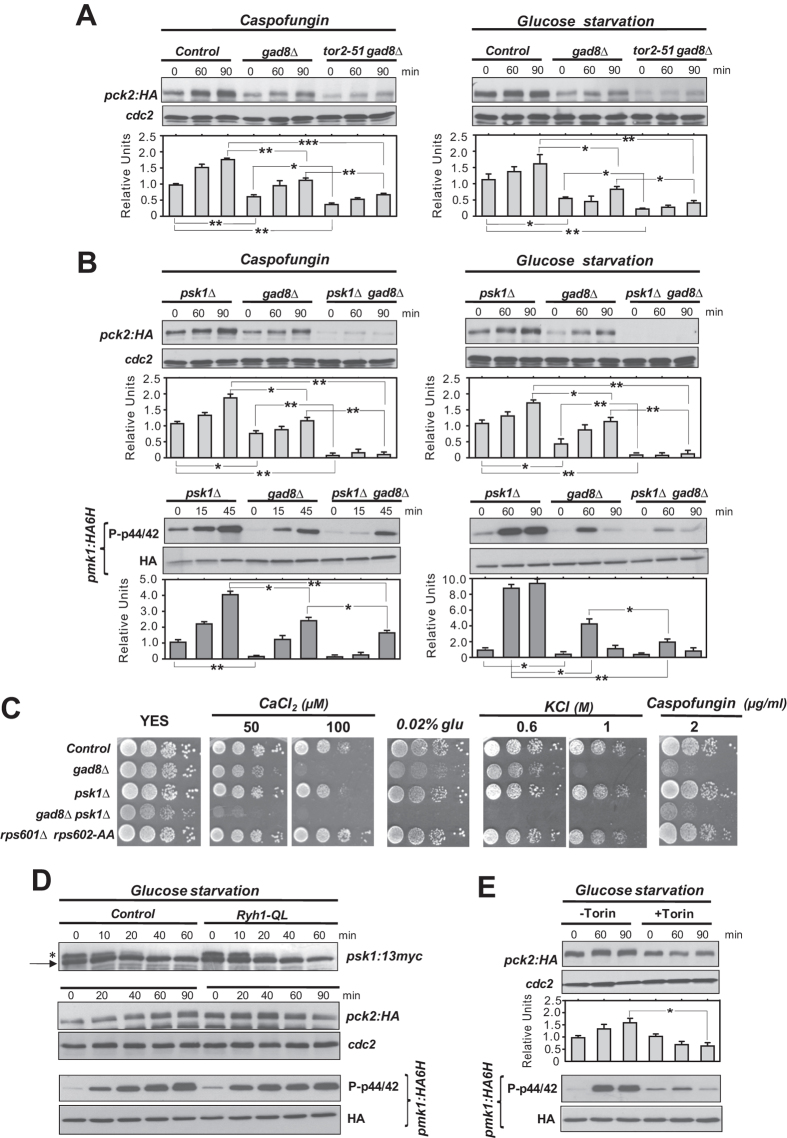
TORC1-Psk1 participates with TORC2-Gad8 in increasing Pck2 levels and Pmk1 activation during growth and stress.(A) Cultures of strains BV8 (Pck2-HA; control), BV11 (gad8Δ Pck2-HA), and BV369 (tor2-51 gad8Δ Pck2-HA) were grown at 25 °C, incubated at 36 °C for one hour, and treated with 1 μg/ml Caspofungin (left panel), or starved for glucose (right panel). Cell extracts were resolved by SDS-PAGE and Pck2 levels detected after incubation with anti-HA antibodies. Anti-Cdc2 was used as a loading control. (B) Upper panels. Growing cultures of strains BV13 (psk1Δ Pck2-HA), BV11 (gad8Δ Pck2-HA), and BV14 (psk1Δ gad8Δ Pck2-HA) expressing genomic Pmk1-HA6H fusions were treated with Caspofungin (left panels), or starved for glucose (right panels), and Pck2 levels were detected as described above. Lower panels. Pmk1-HA6H fusion was purified by affinity chromatography, and activated/total Pmk1 detected with anti-phospho-p44/42 and anti-HA antibodies, respectively. *P < 0.05; **P < 0.005. (C) Serial dilutions of suspensions of strain BV78 (rps601Δ rps602-AA Pck2-HA) and of those described in (A) and (B), were spotted on YES plates supplemented with different concentrations of CaCl2, KCl, Caspofungin, or glucose, and incubated for 3 or 5 days (low glucose plates) at 28 °C. (D) Strains AN0179 (Psk1-13myc) and BV90 (Ryh1-QL Psk1-13myc) expressing genomic Pmk1-HA6H fusions were grown in YES medium and starved for glucose. The Psk1-13myc fusion was detected after incubation with anti-myc antibodies. Pck2 levels were detected as described above. Activated/total Pmk1 detected with anti-phospho-p44/42 and anti-HA antibodies, respectively. Arrow, unphosphorylated Psk1; asterisk, TORC1-phosphorylated Psk1. (E) A growing culture of control strain BV8 (Pck2-HA) expressing a genomic Pmk1-HA6H fusion was incubated with 50 μM Torin for 60 min or remained untreated (DMSO). These cells were then starved for glucose for the indicated times. Pck2 was detected as described above. Activated/total Pmk1 detected with anti-phospho-p44/42 and anti-HA antibodies, respectively. *P < 0.05 in Torin–treated cells as compared to the untreated culture.